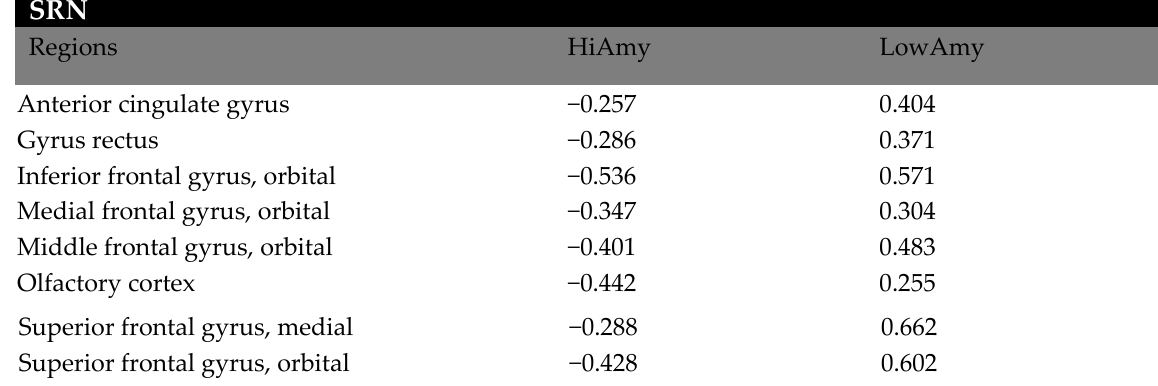
Figure 6. Correlation between A β burden and IFC in SRN.